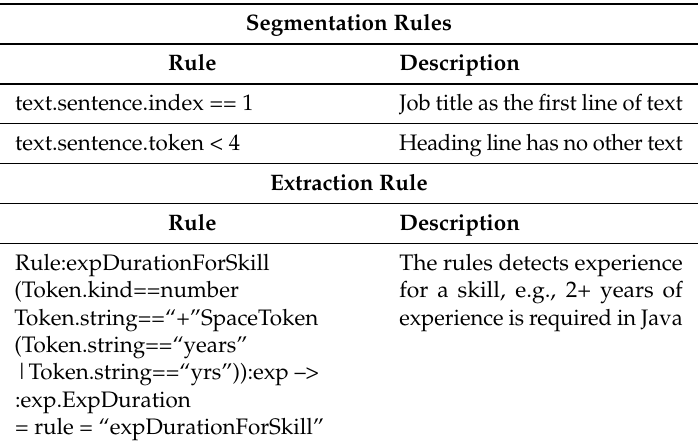
Table 1. Sample rules designed for segmentation and extraction with